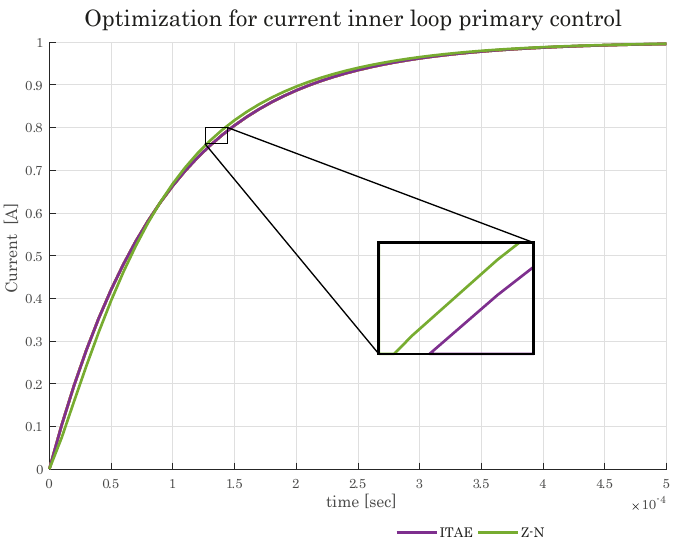
Figure 10. The optimization techniques for the current inner loop of the primary control are